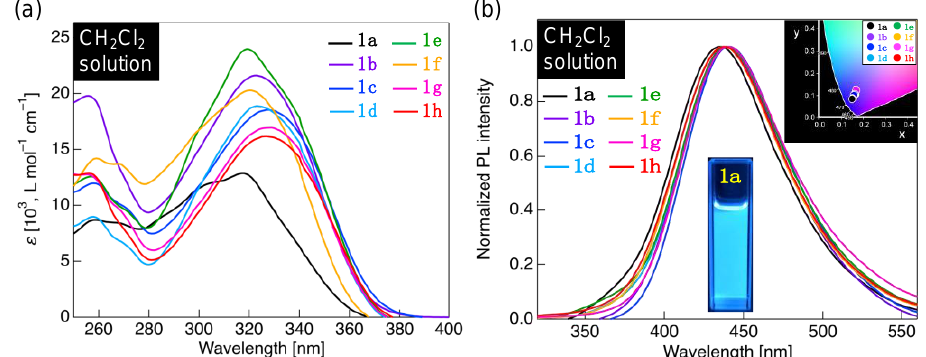
Figure 6. ( a ) Ultraviolet (UV) – visible absorption spectrum of 1a – h in the CH 2 Cl 2 solution (concen-